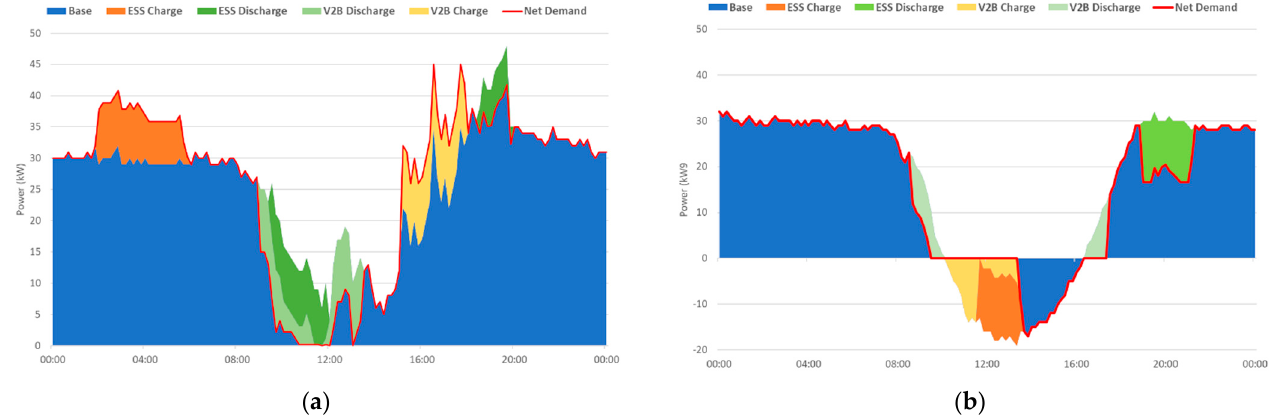
Figure 10. Scenario B: weekday ( a ); weekend ( b ).